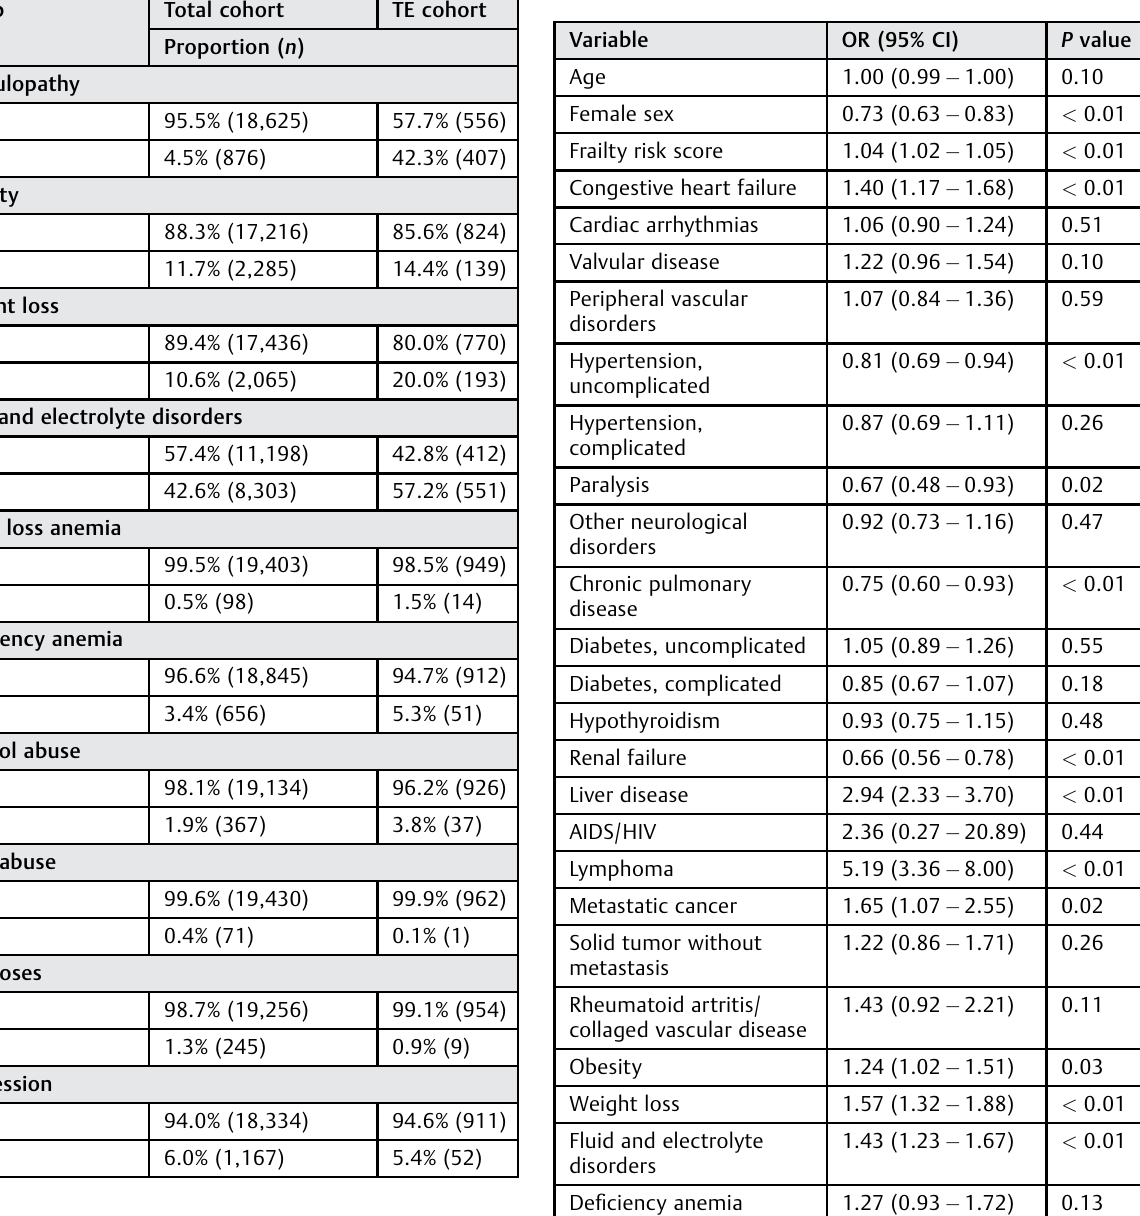
Table 2 Results of multivariable analyses of thromboembolic